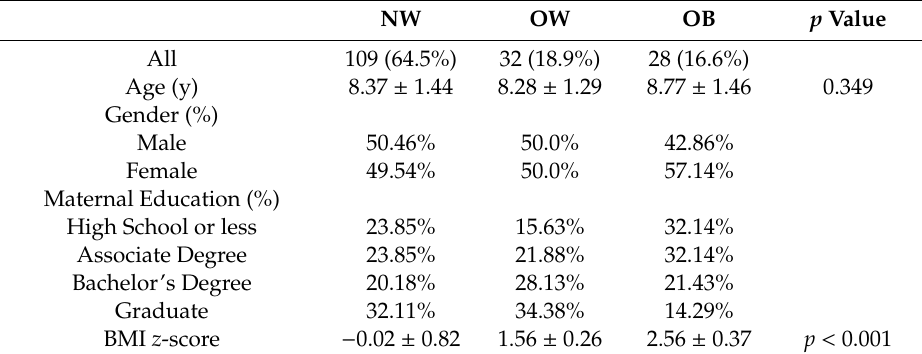
Table 1. Descriptive characteristics of study population.